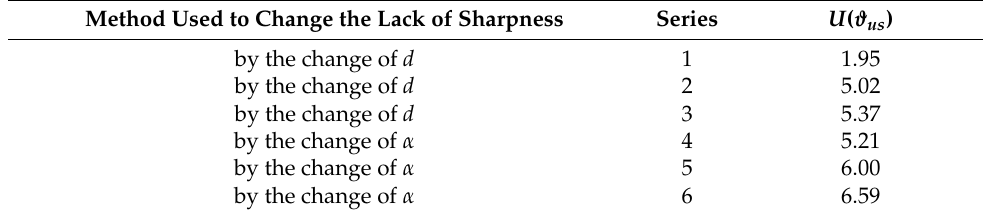
Table 5. Obtained values U ( ϑ us ) for k =